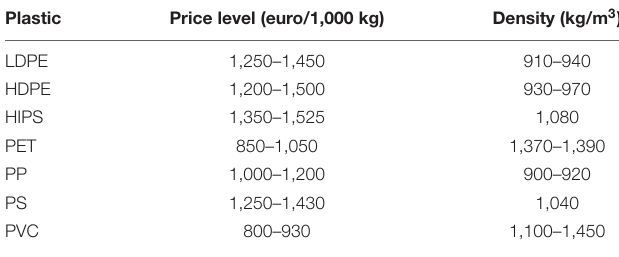
TABLE 3 | Price level for fossil-based plastics.